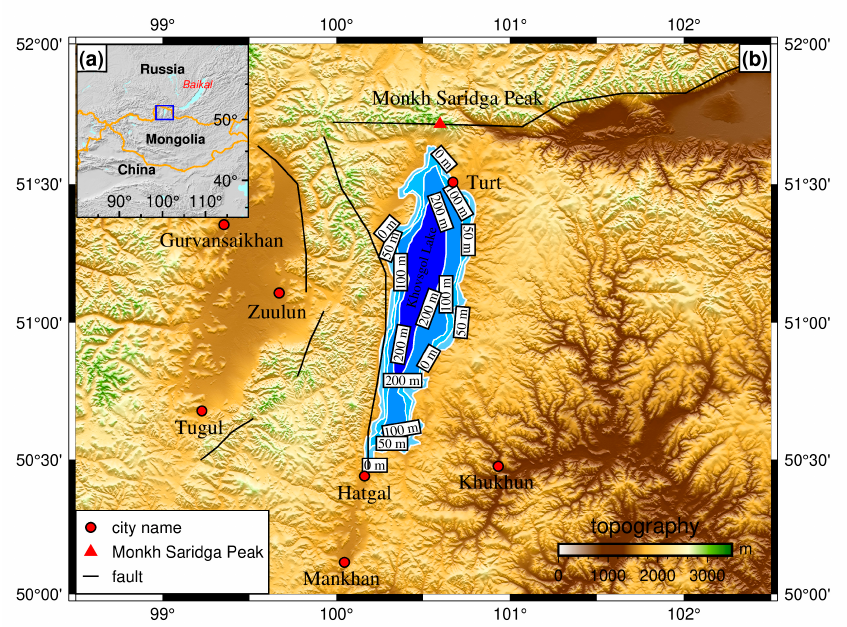
Figure 1. ( a ) Overview map of the Mongolian Plateau and surrounding country regions. It is superimposed on 2-arcminute SRTM Digital Elevation Model (DEM), the blue area is the location of Lake Khovsgol. ( b ) Map of the topography structure around Lake Khovsgol and the bathygram of the lake. It is superimposed on 3 Arc-Second Global SRTM Digital Elevation Model (DEM) with 90 m resolution. The different background colors indicate different elevations.